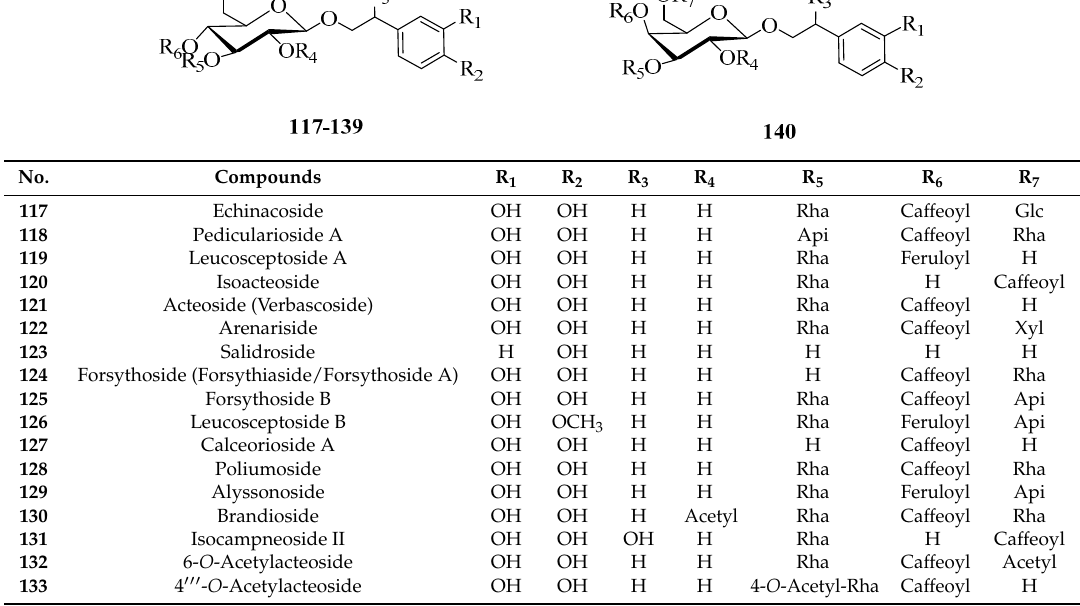
Table 2. The old phenylethanoid glycosides whose pharmacological effects were reported after 2008.